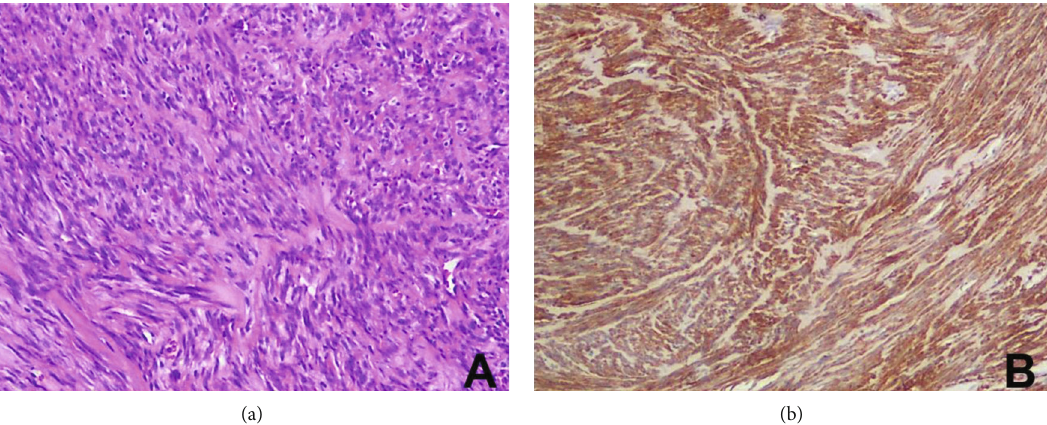
Figure 4: (a) Proliferation of spindle cells arranged in interlocking bundles in a monotonous pattern of fascicles (hematoxylin and eosin stain;